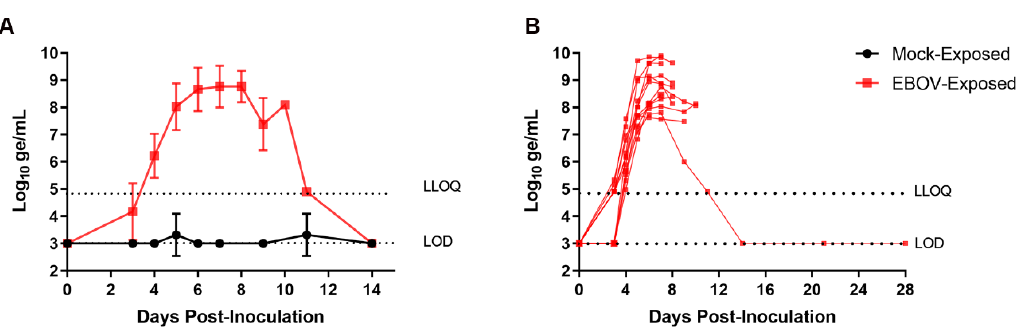
Figure 3. Group mean and individual animal plasma viral RNA: ( A ) group mean ± SD of plasma viral RNA versus time; and ( B ) plasma viral RNA concentration in individual EBOV-exposed animals versus time. LOD, limit of detection, Ct = 38.07; LLOQ, lower limit of quantitation = 4.903 log 10 ge / mL. For display and analyses, EBOV RNA values below the LOD were imputed as 3.000 log 10 ge / mL; values above the LOD but below the LLOQ were imputed as 4.903 log 10 ge / mL. Statistical analyses were not performed.